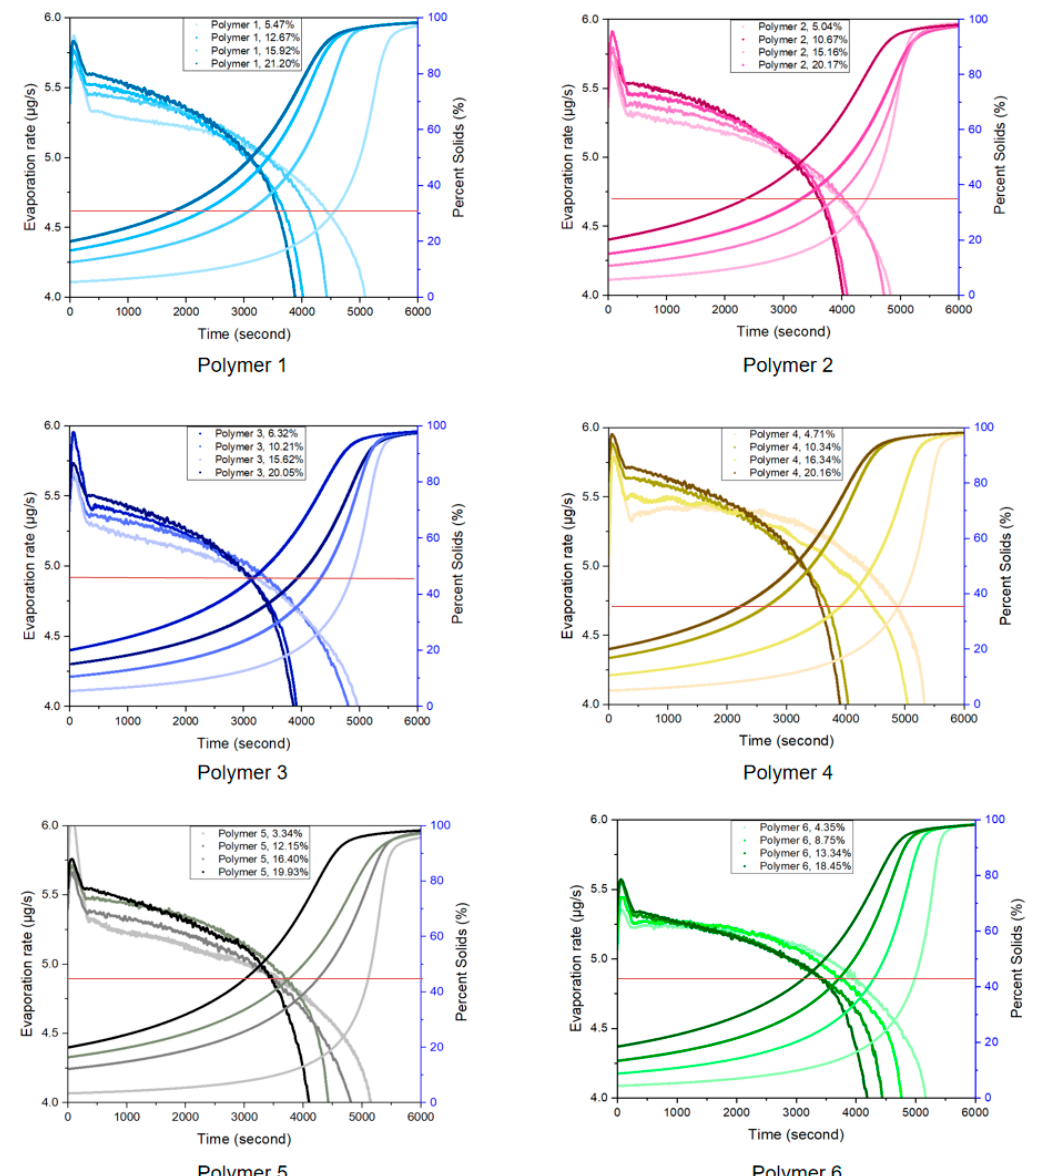
Figure 11. Evaporation rate at various percent solids for Polymer 1–6.